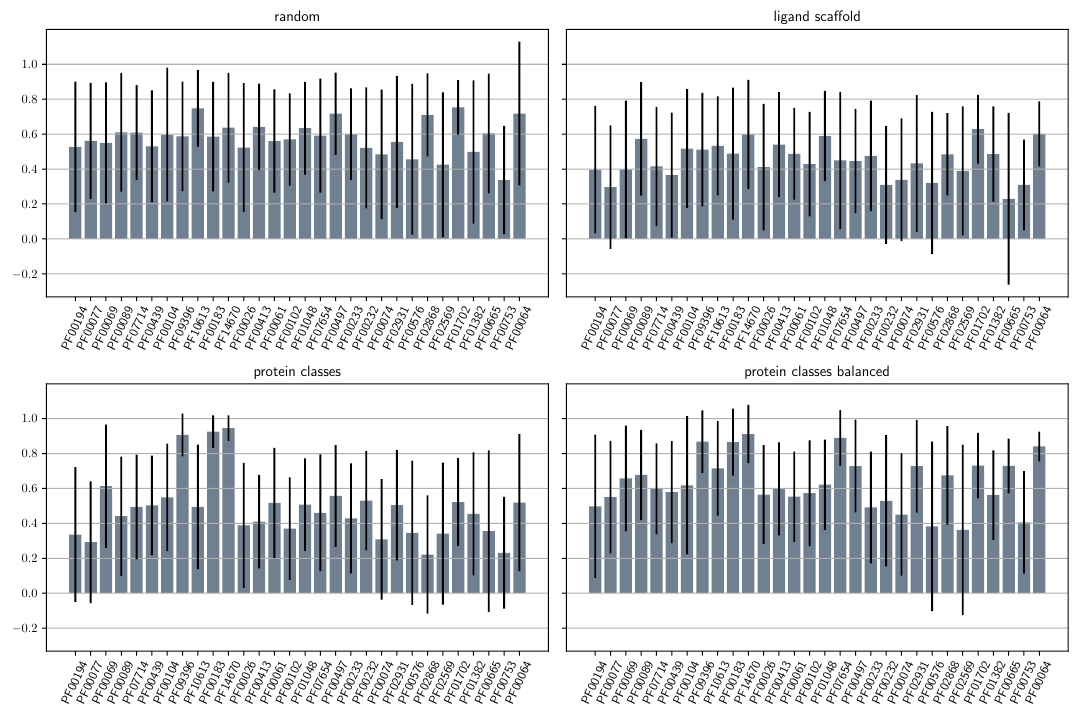
Figure 3. Average Pearson’s R correlation coefficient for the RMSD ave metric for all types of splits disaggregated into the 30 most populated PFAM families in the PDBbind refined